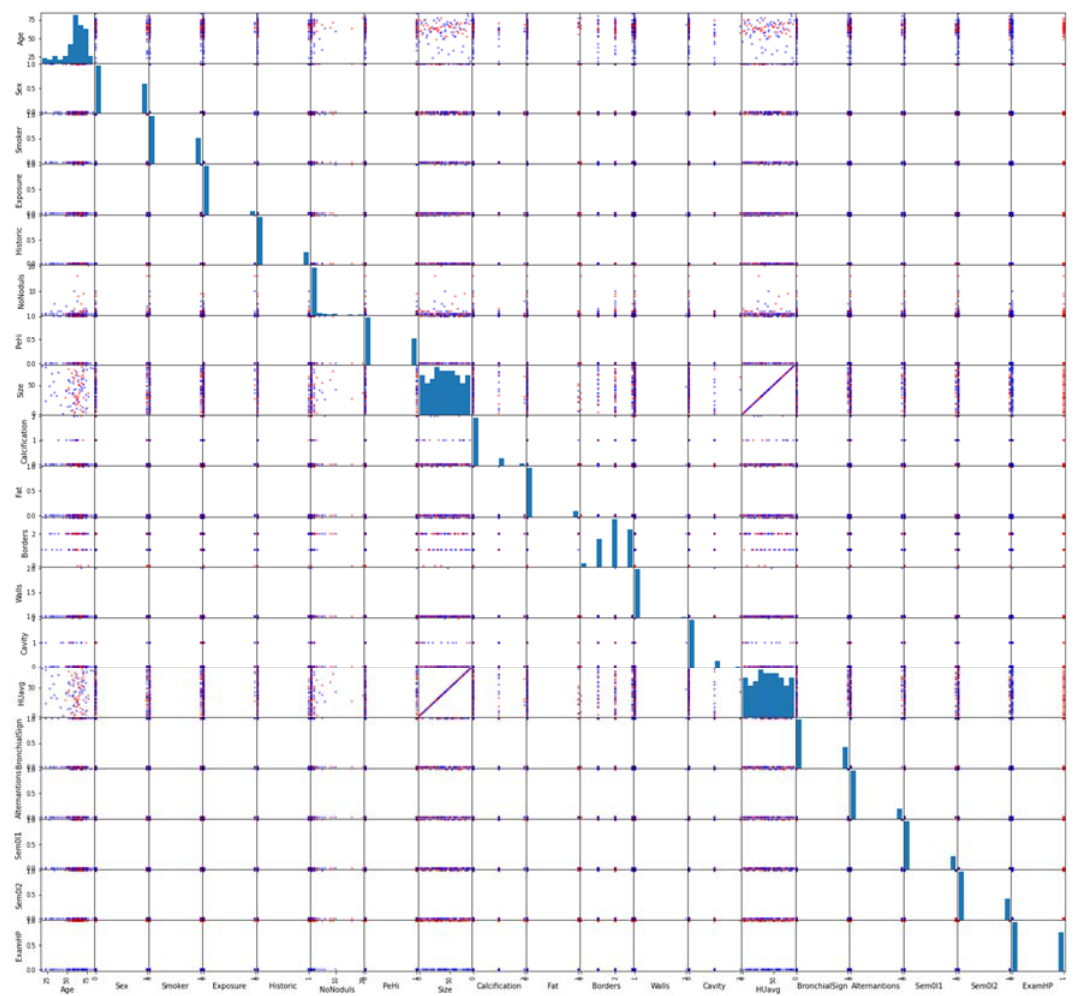
Figure 7. Cancer incidence probability